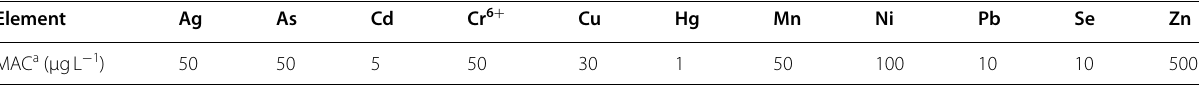
Table 1 Water quality standards of TEPA for heavy metal content in surface